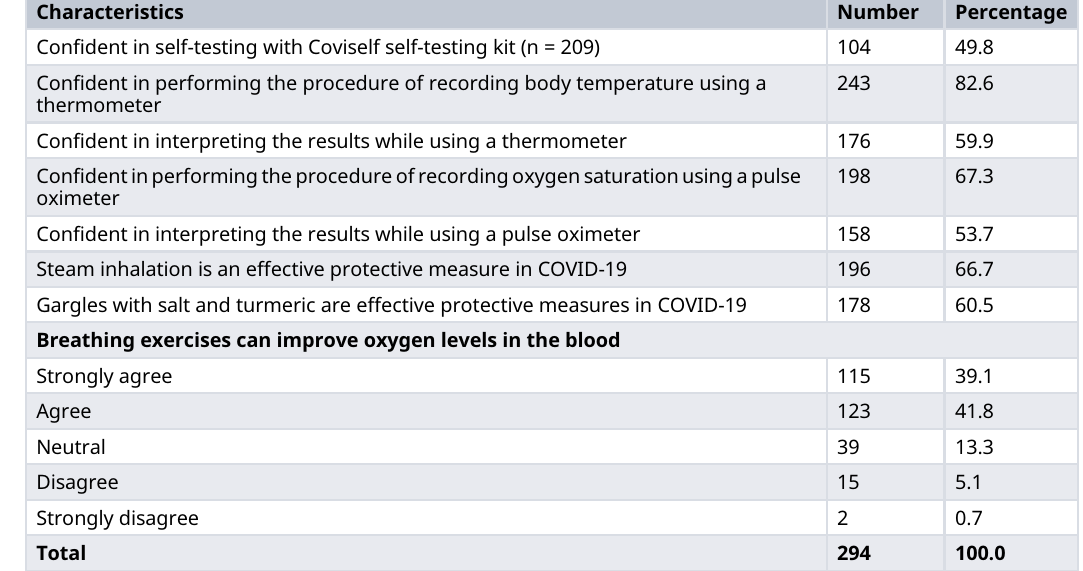
Table 6. Perception of participants regarding various COVID-19 protective measures.